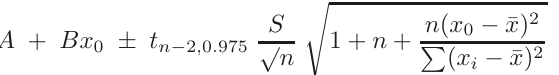
Fig. 4. A set of data { x i , y i } for i = 1 , . . . , 7 obtained when studying the function f ( x ), and an evaluated 95% con- fidence interval for f ( x 0 ). The interval lies between dotted curves that show the functions a + bx ± t n − 2 , 0 . 975 ( s/ (cid:9) (cid:5) 1 + n ( x − ¯ x ) 2 / ( x i − ¯ x ) 2 . (The hollow markers give the limits of the evaluated prediction interval described in Example